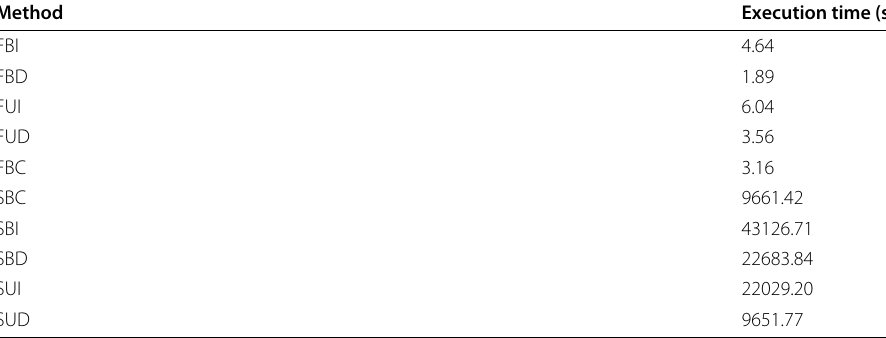
Table 3 Execution time for different variations of Algorithm 1, for 20 nodes, p53 data set Method